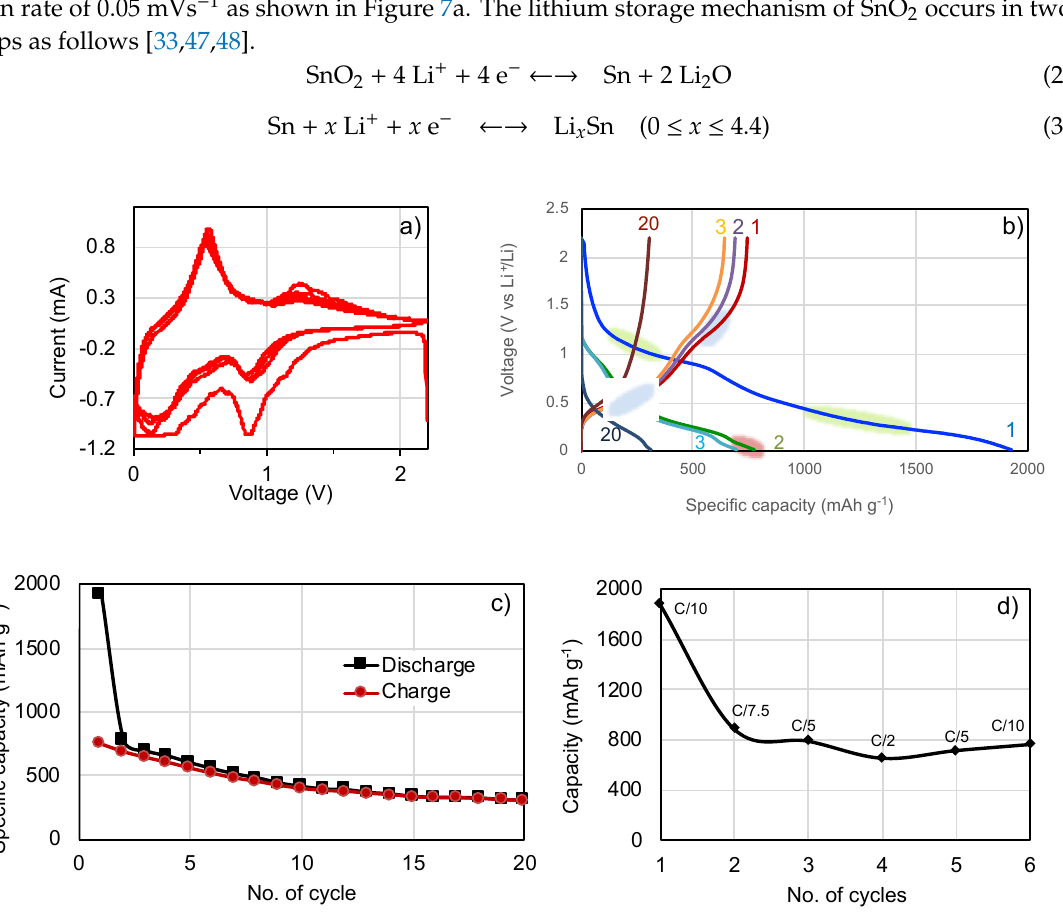
Figure 7. Cyclic voltammetry analysis of SnO 2 @C nano-rattles at 0.05 mV s − 1 ( a ). Charge and discharge curves ( b ) and cyclability ( c ) of SnO 2 @C composite electrode at C / 5 for 20 cycles. Rate capability test at different C -rates for coin cells with electrode based on SnO 2 @C nano-rattles ( d ).